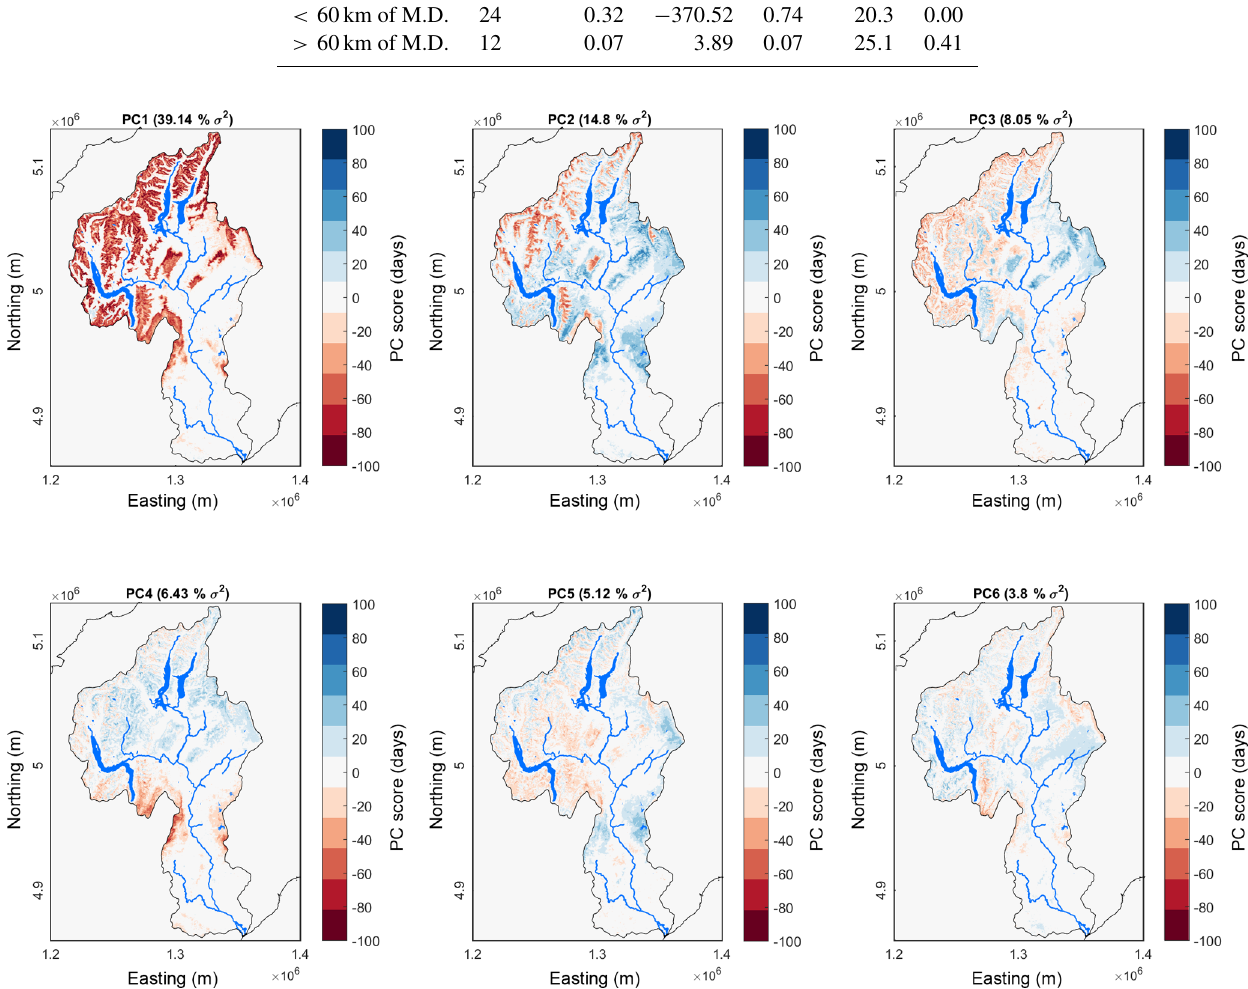
Figure 11. The first six spatial principal components of the SCD anomaly.